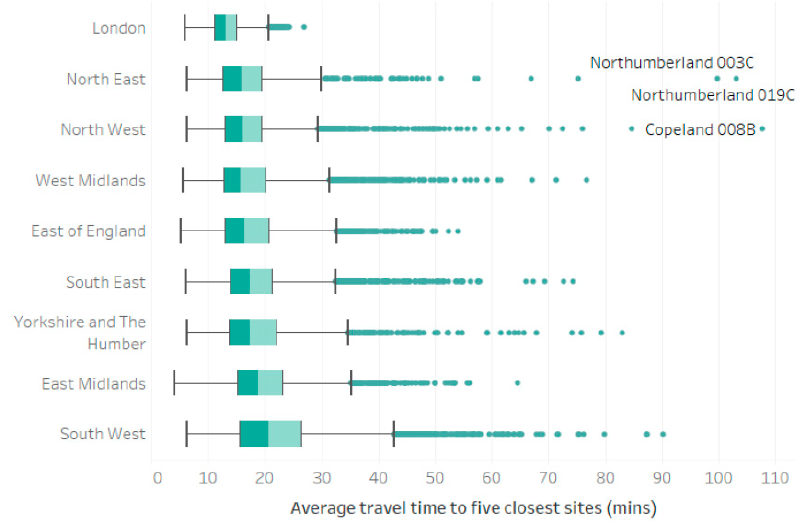
Figure 3. Average journey times to five closest vaccination sites by all modes of transport (weighted to account for inferred usage based on LSOA level split between car and public transport), grouped by region.